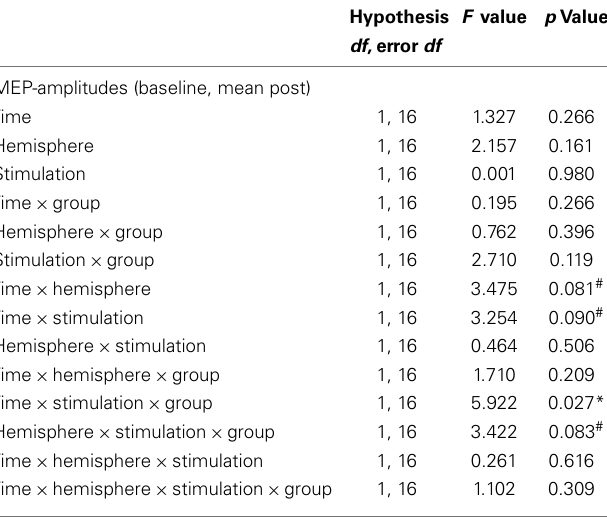
Table 3 | Results of the RM-ANOVAs for MEP